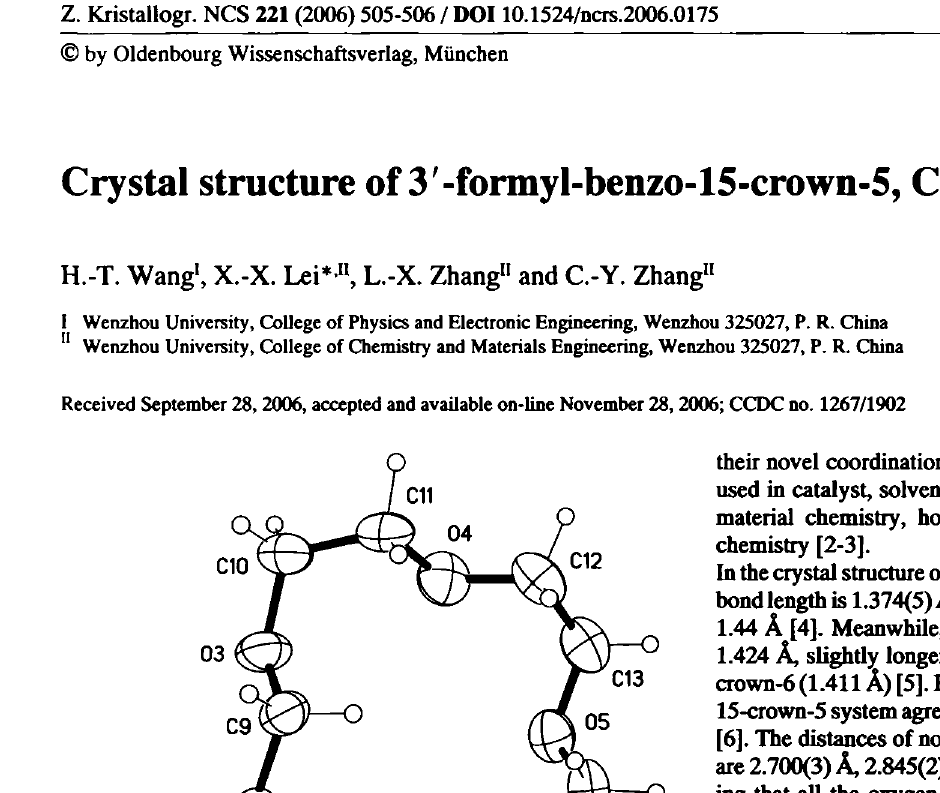
Table 1. Data collection and handling.